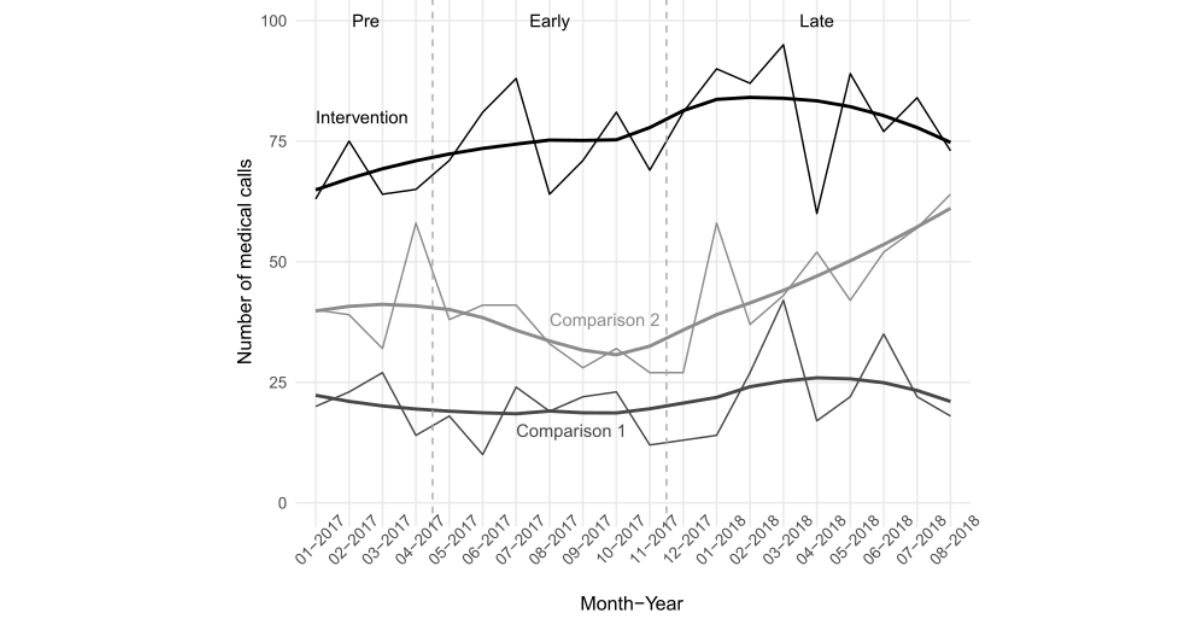
Figure 1. Number of medical calls at the intervention and the two comparison communities. Dashed vertical lines indicate the demarcations between Pre and Early periods (ie, the start of telemedicine in May 2017) and between Early and Late periods (ie, the start of the new telemedicine use policy in December 2017).